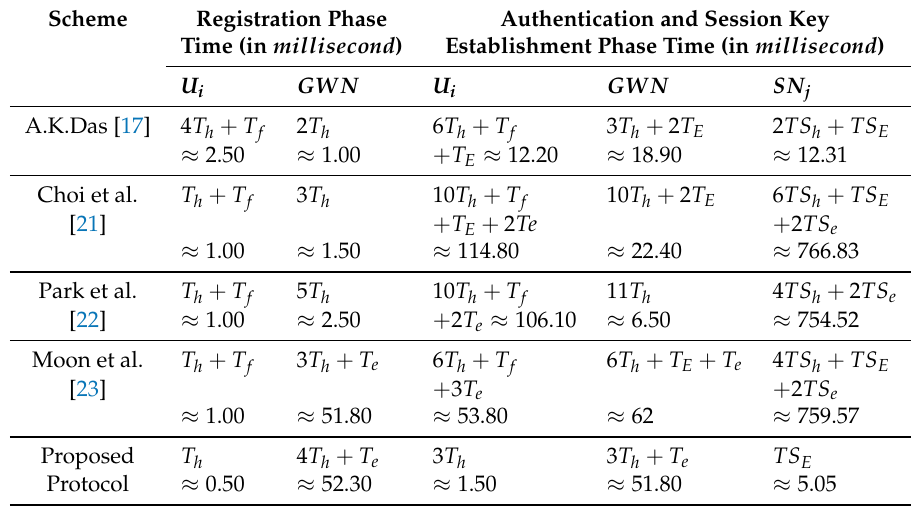
Table 27. Comparison of protocols based on computational